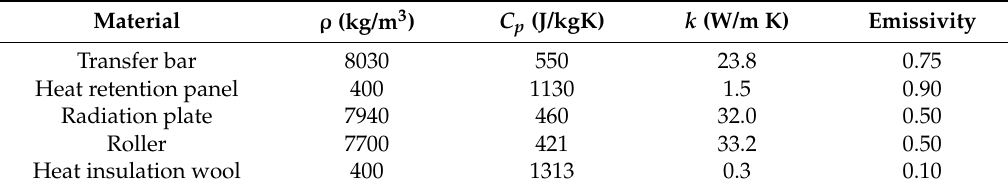
Table 1. Thermal properties of the heat retention panel system.